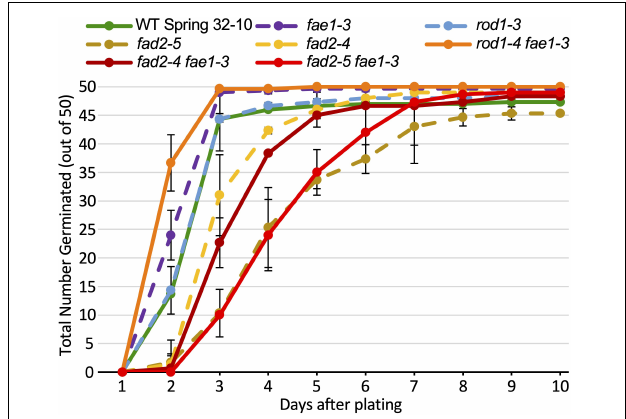
FIGURE 4 | Amounts of seed germination over a 10-day period of the different lipid mutants versus wild type grown at 22 ◦ C. One hundred and fifty seeds from each line were plated on three agar growth media plates (50 seeds per plate; each plate treated as a biological rep). The data for single mutants are graphs as dashed lines, whereas double mutants and wild type (WT) are graphed as solid lines. Error bars represent standard deviations of the means. Values and significant differences can be found in Supplementary Table 2 .